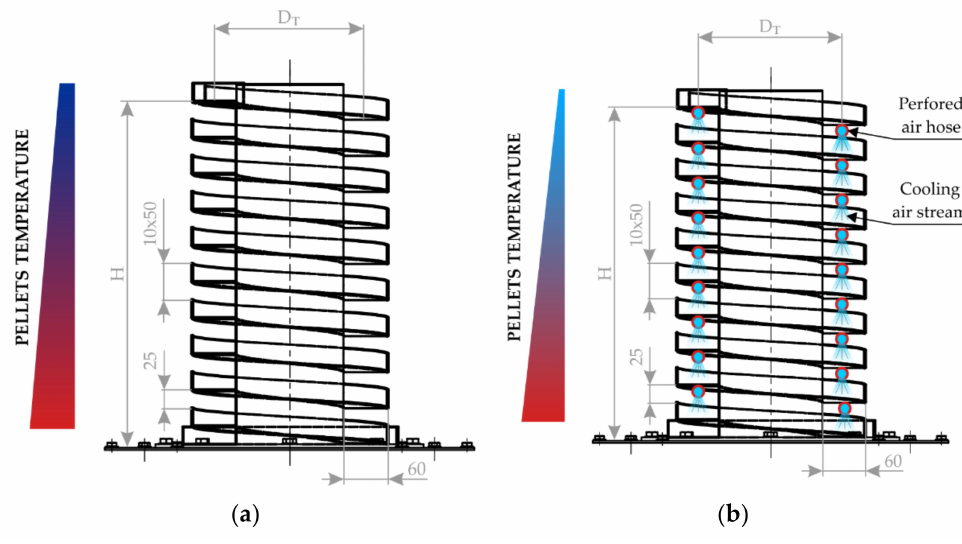
Figure 5. Variants of construction arrangement: ( a ) Variant A—spiral trough; ( b ) Variant B—spiral trough with perforated air hose cooling system.